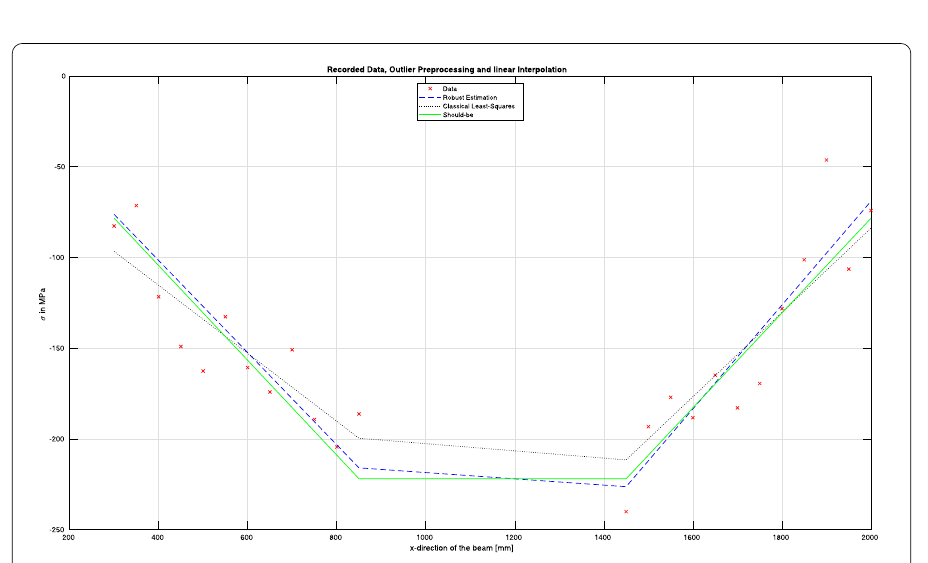
Figure 17 The final estimation of the lab tested, coated beam. The classical approach leads to an unsatisfactory evaluation. Therefore, a robust weight function has been in use too, which improves the